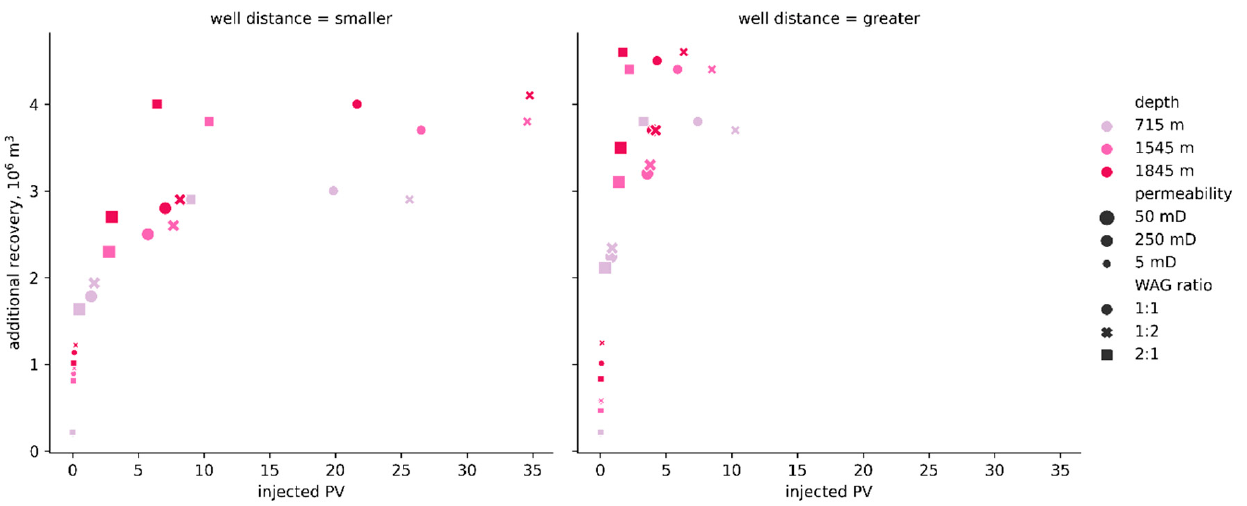
Figure 5. Additional recovery versus injected pore volumes (PVs) after 15 years of EOR. Retention was also highest for the cases with smaller well distances and a WAG ratio of 1:2 since much more CO 2 could be injected in the case of smaller distances and a WAG ratio of 1:2 was the ratio in which CO 2 was injected for the longest period (Figure 6).